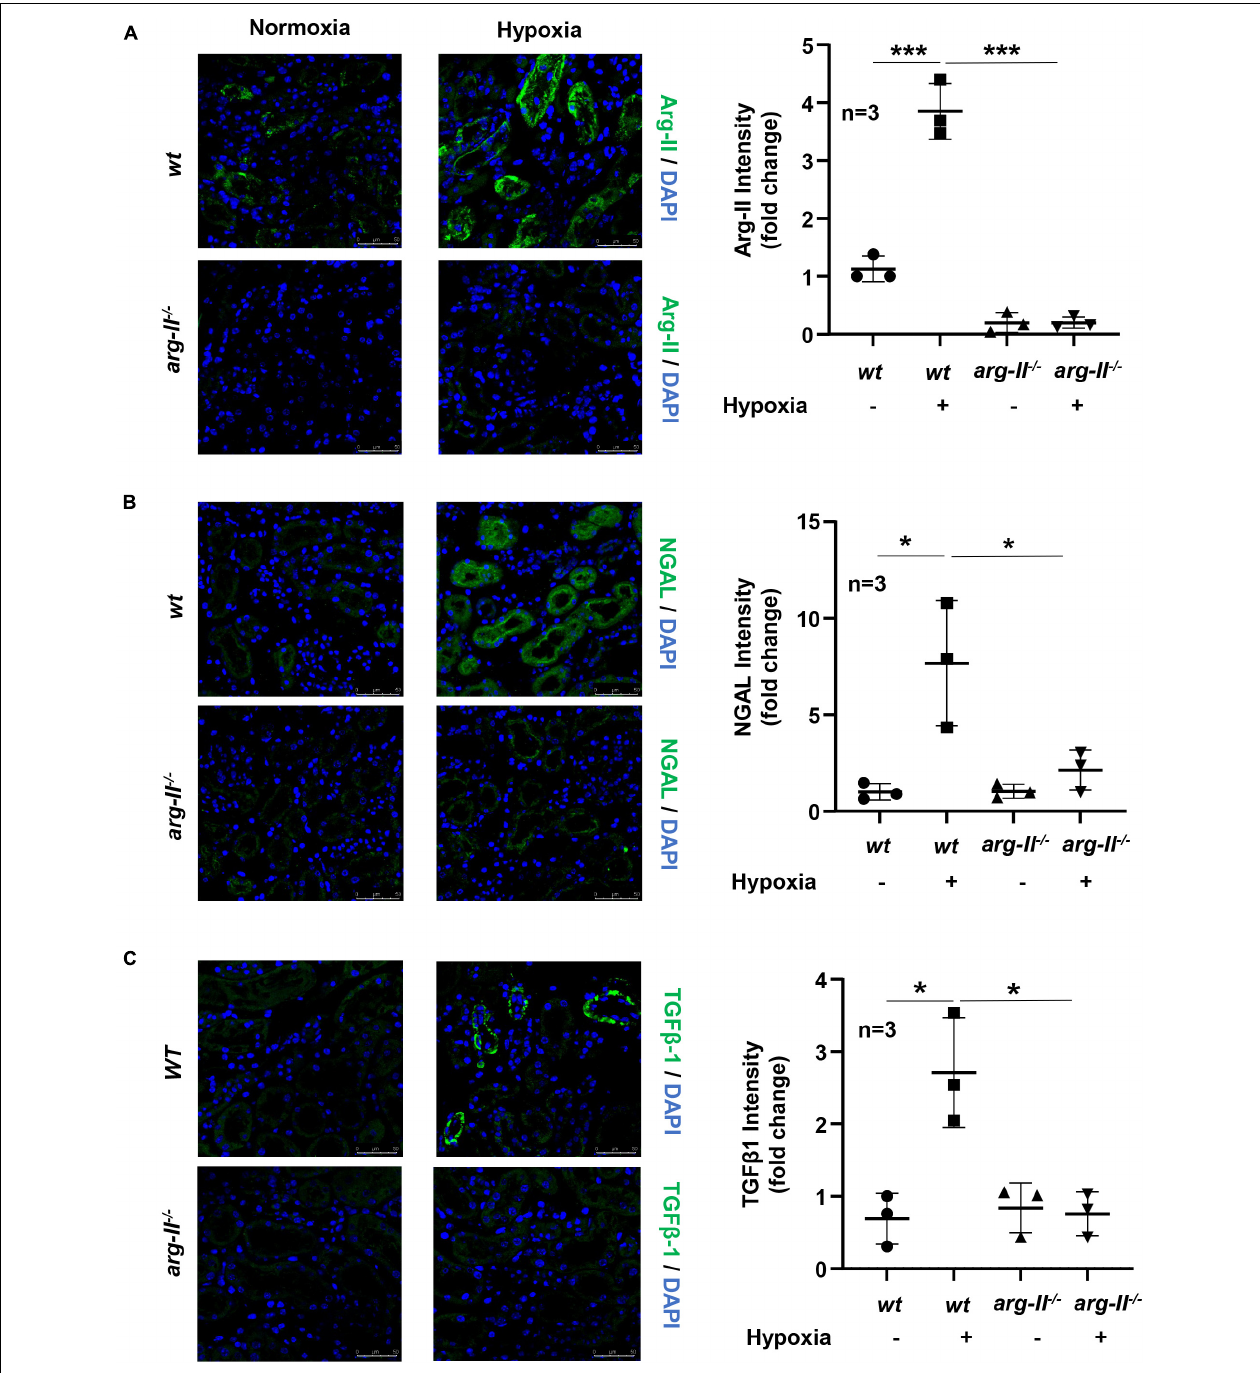
FIGURE 7 | Effects of Arg-II deficiency on hypoxia-induced damage in kidneys. Confocal immunofluorescence staining of (A) Arg-II, (B) NGAL and (C) TGF β 1 and DAPI (blue) in ex vivo isolated kidneys of wt and arg-II - / - mice exposed to normoxia and hypoxia conditions (1%, 24 h). Representative images of merged images are shown ( n = 3 animals per group). Quantifications of fluorescence intensity signals are shown in the bar graphs on the right. * p < 0.05, *** p < 0.001 between the indicated groups. Scale bar = 50 µ m. ANOVA with Bonferroni post hoc test was performed.